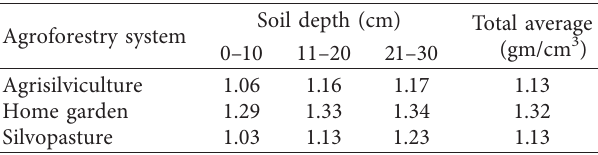
Table 3: Average soil organic carbon percentage at various depths and agroforestry systems.